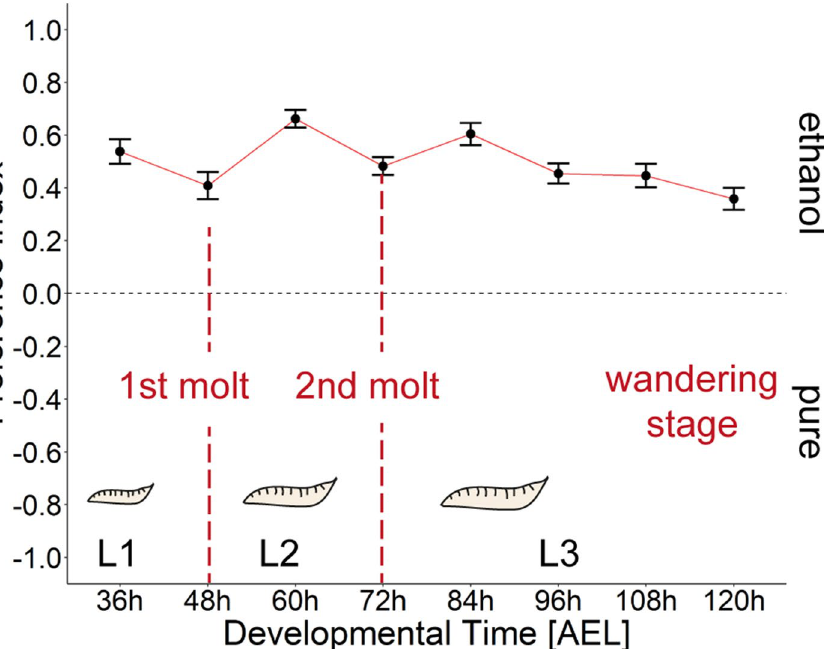
Figure 2. Ethanol substrate choice during larval development. Canton-S larvae are attracted to 8% ethanol throughout the post-embryonal development. Data points represent the median behavioral response (substrate choice) according to the time after egg laying (AEL). Note a decrease of the behavioral response to some time points (48 h AEL, 72 h AEL, 96 h–120 h AEL) which correlates to larval molting events. Statistics are presented in Table 1.